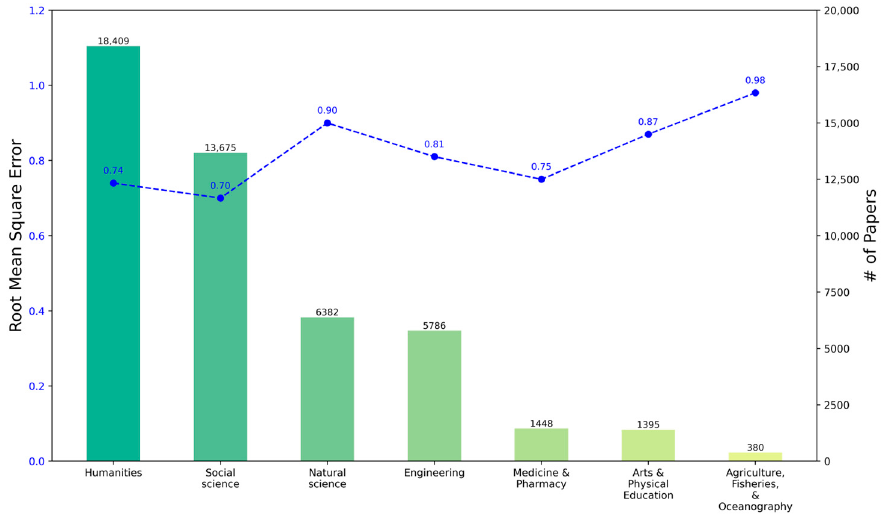
Figure 8. Accuracy (as captured by the RMSE value) of reviewer matching by domain. Table 5 summarizes the comparison results with the baseline and proposed